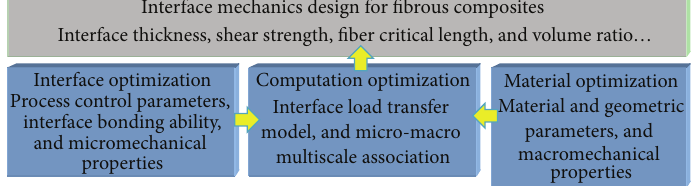
Figure 1: Interface design routes for fiber